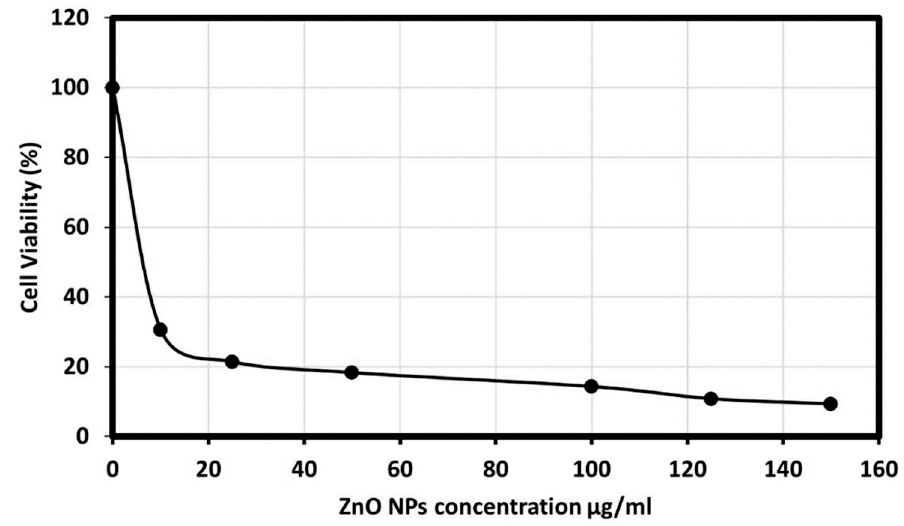
Figure 7. Morphological changes of HCT- 116 cell line due to the cytotoxicity effect of ZnO NPs. (( A ). Control. ( B ). Morphological changes in the cell after 24 h. scale bars = 200 μ m).